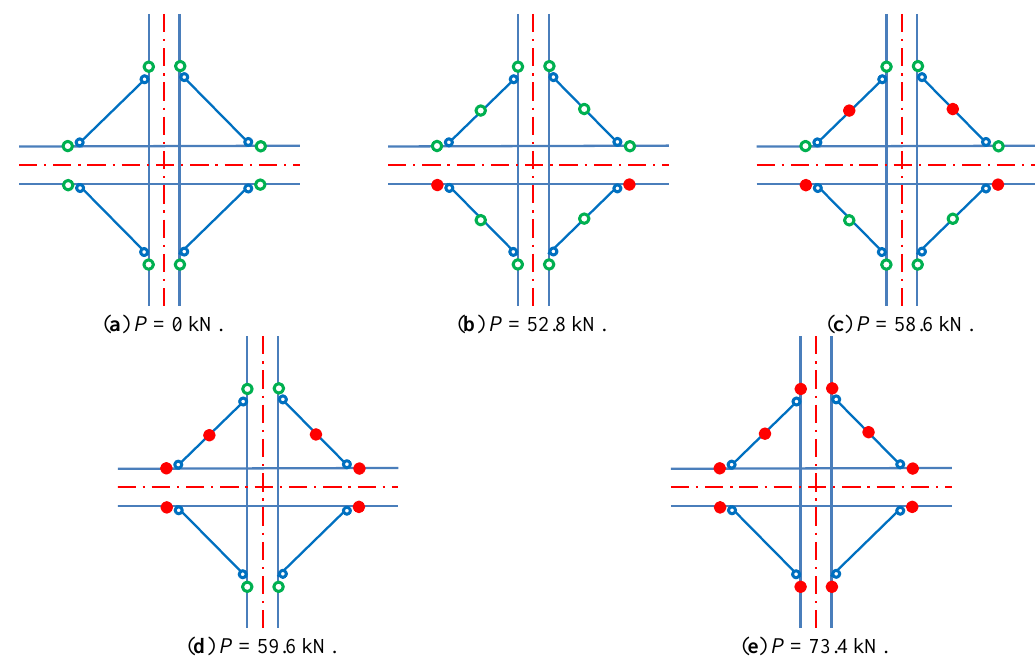
Figure 27. Failure procedure of IC_OB_B specimen.